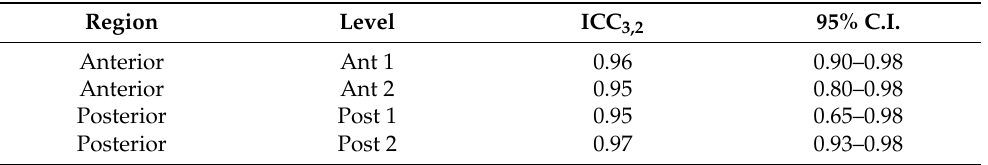
Table 4. Intra-rater reliability of the ultrasound measurements within different regions/levels of the deep fascia of the forearm between two sessions by